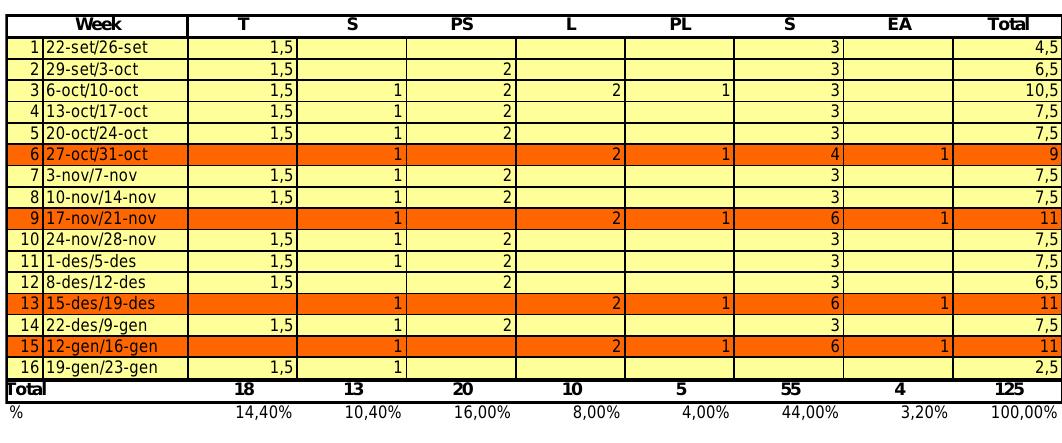
Table 2: Weekly distribution of subject activities and duration in